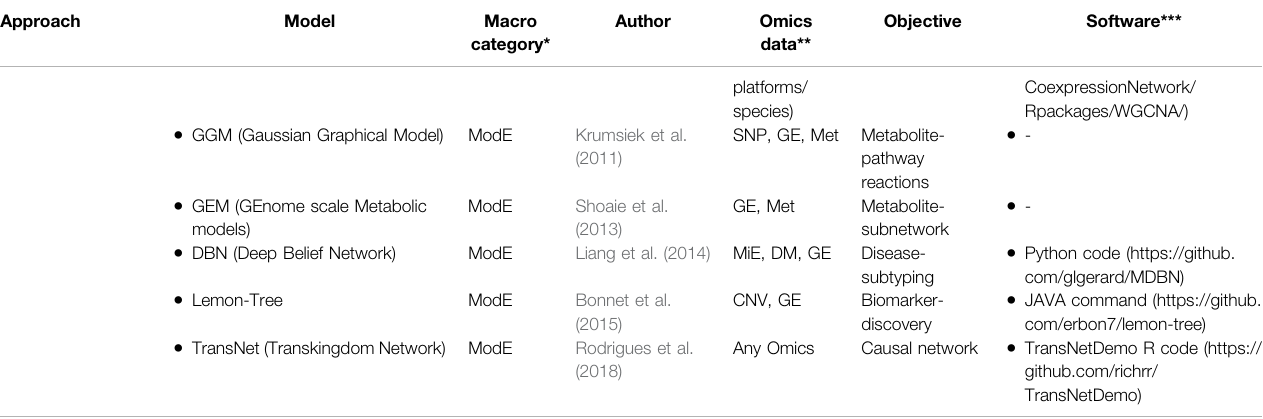
TABLE 4 | ( Continued ) Low-level: Network-based unsupervised integration